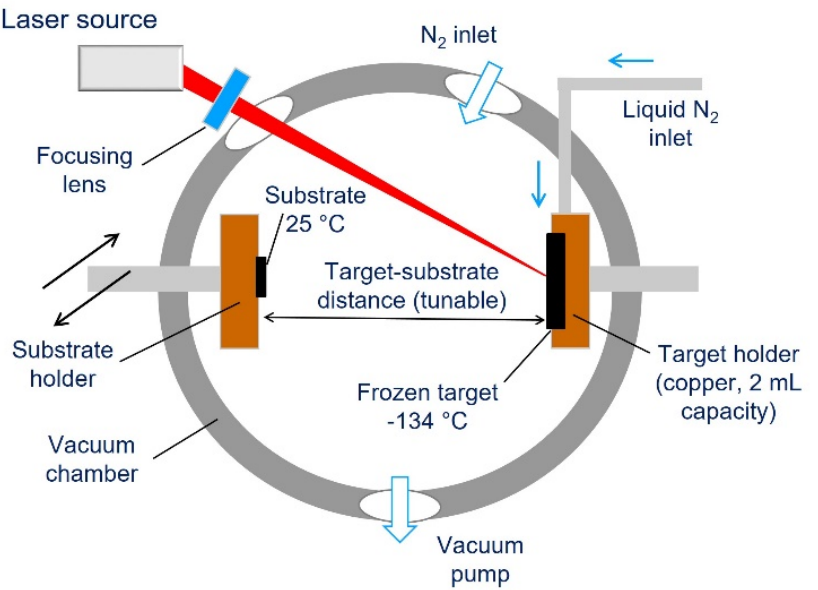
Figure 1. Schematic representation of the deposition system. The substrate holder can be moved to tune the inter distance between target and substrate (black arrows).